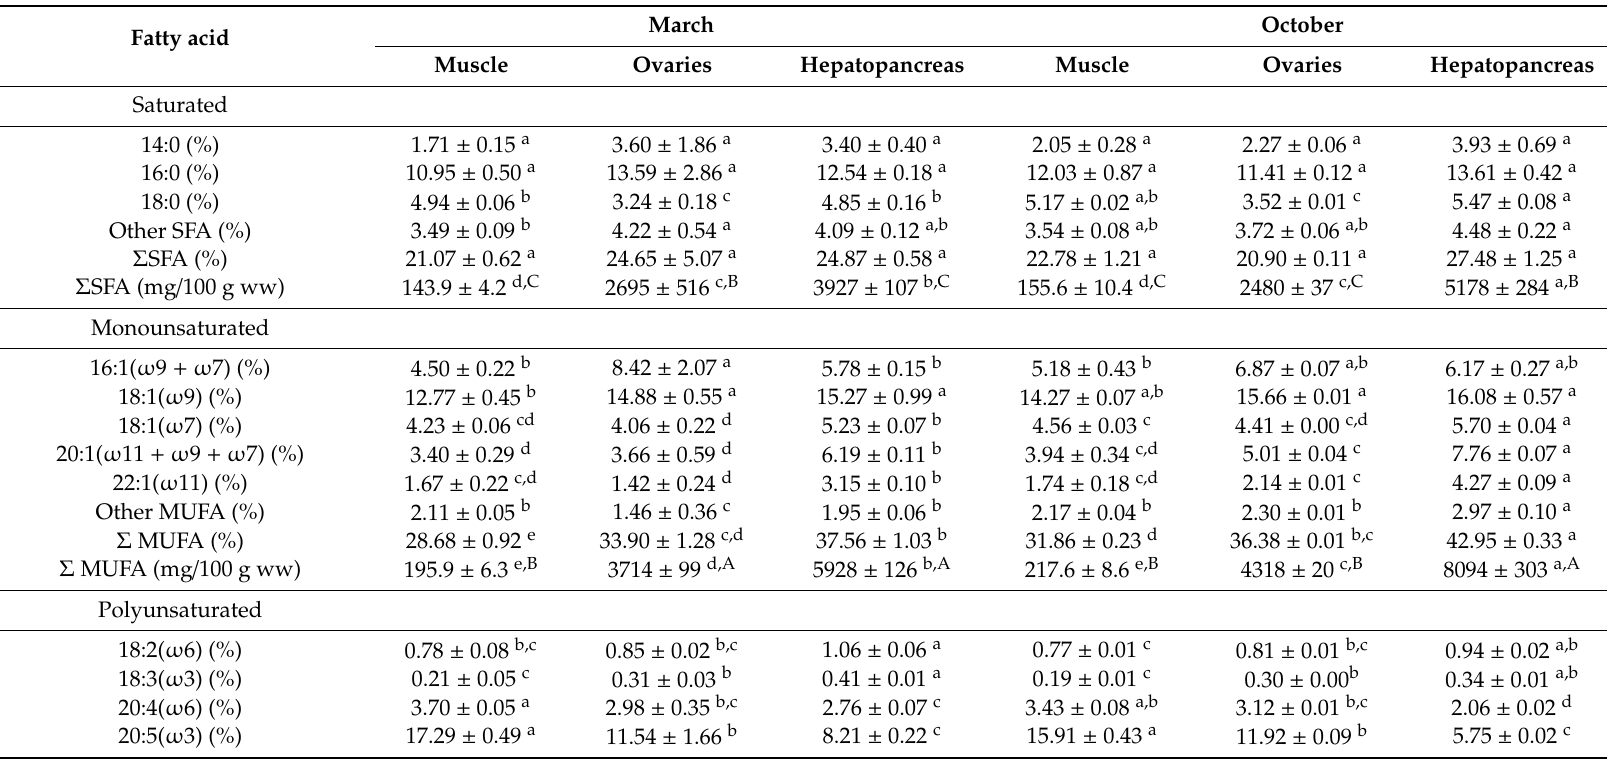
Table 3. Fatty acid and cholesterol composition of boiled C. maritae caught in March and October (average ± standard deviation). Fatty